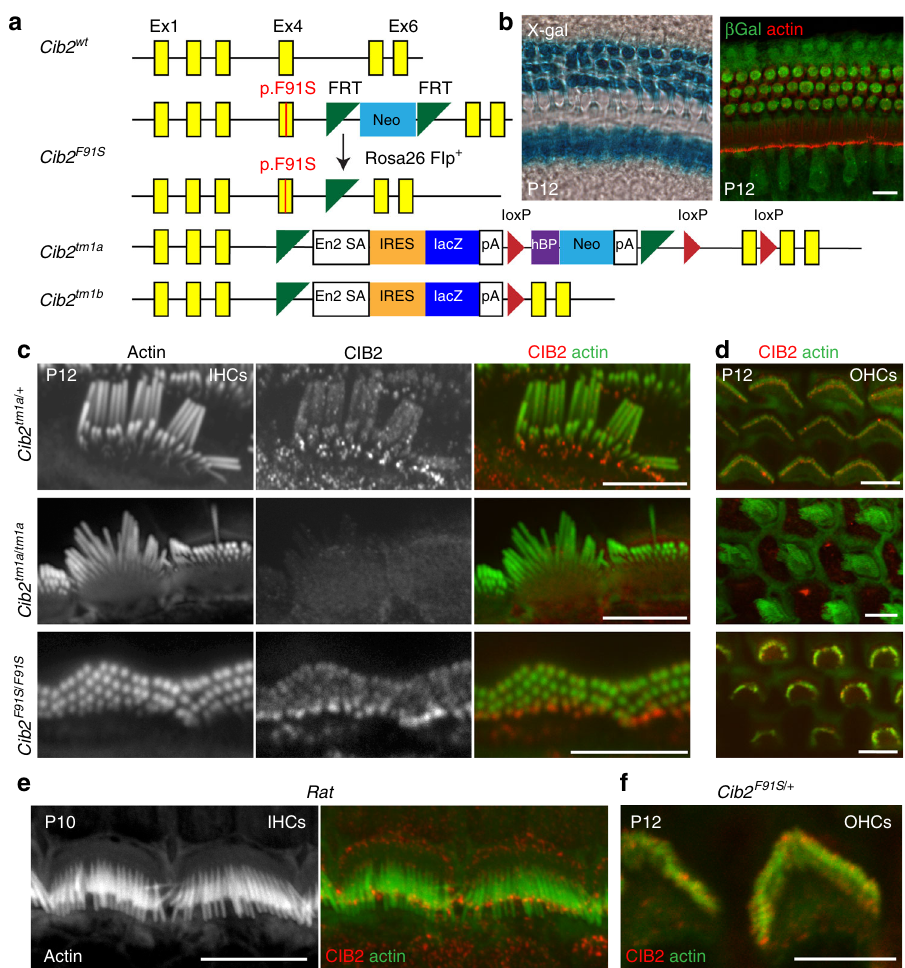
Fig. 1 CIB2 is localized in the auditory hair cell stereocilia. a Structure of the wild-type, the Cib2 F91S and the Cib2 tm1a(EUCOMM)Wtsi ( Cib2 tm1a , EUCOMM) alleles. b X-gal staining to document the Cib2 locus activity in the organ of Corti of P12 Cib2 tm1a/ + mice ( left ). Immunolocalization of β -galactosidase ( green ) in Cib 2tm1a/ + mouse cochlea at P12 ( right ). The cochlear actin is labeled with rhodamine – phalloidin ( red ). c , d Confocal images of IHC ( c ) and OHC ( d ) stereocilia bundles immunostained with CIB2 antibody ( middle panels in c and red in the merge panels ), and actin was labeled with phalloidin ( left panels in c and green in the merge panels ) in the control Cib2 tm1a/ + , Cib2 tm1a/tm1a , and Cib2 F91S/F91S mice at P12. Note that Cib2 truncation causes disappearance of CIB2 protein from stereocilia, while p.F91S mutation does not. e CIB2 localization in the rat IHC stereocilia at P10. f CIB2 localization at P12 in Cib2 F91S/ + OHCs. Scale bars: b 10 μ m, c – f 5 μ